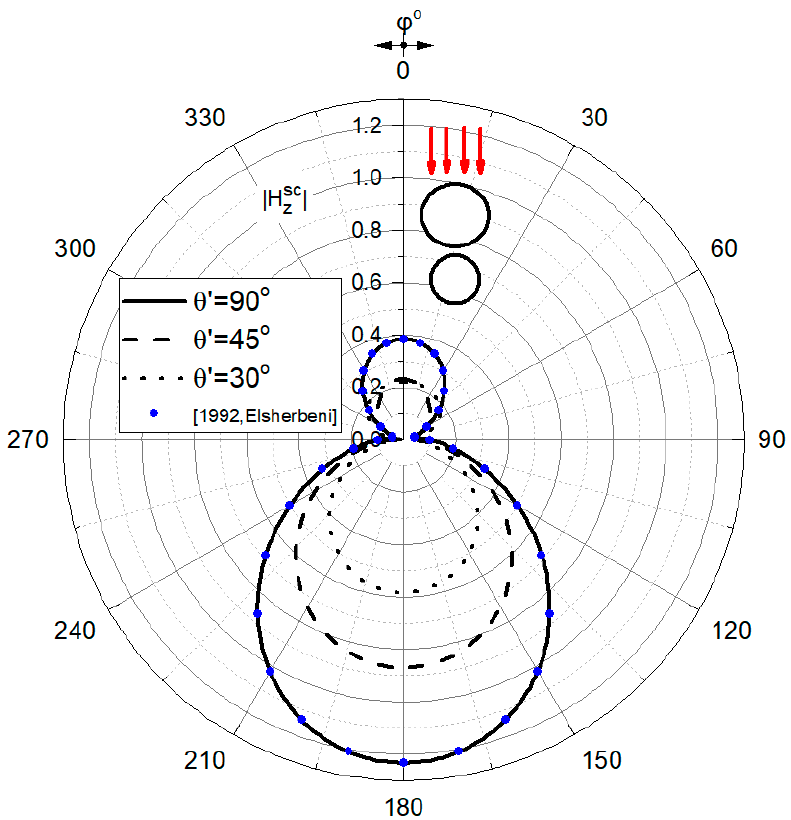
= ϕ Figure 4. The far magnetic field pattern ( ϕ = ϕ 1 ) for the inset structure, arising from that of Figure 1 Figure 4. The far magnetic field pattern ( 1 φ ) for the inset structure, arising from that of Figure 1 when L = 3, D 23 = 0.4 λ 0 , ε 1 = ε 2 = ε 4 = ε 0 , α 3 = 0.1 λ 0 , α 5 = 0.2 λ 0 , ε 3 = ε 5 = 2 ε 0 , µ i = µ 0 and when L = 3, σ i = 0 ( i = 1,2,3,4,5), while E 0 = 0, H 0 = 1, ϕ (cid:48) = 0 ◦ and θ (cid:48) = 30 ◦ , 45 ◦ , 90 ◦ .